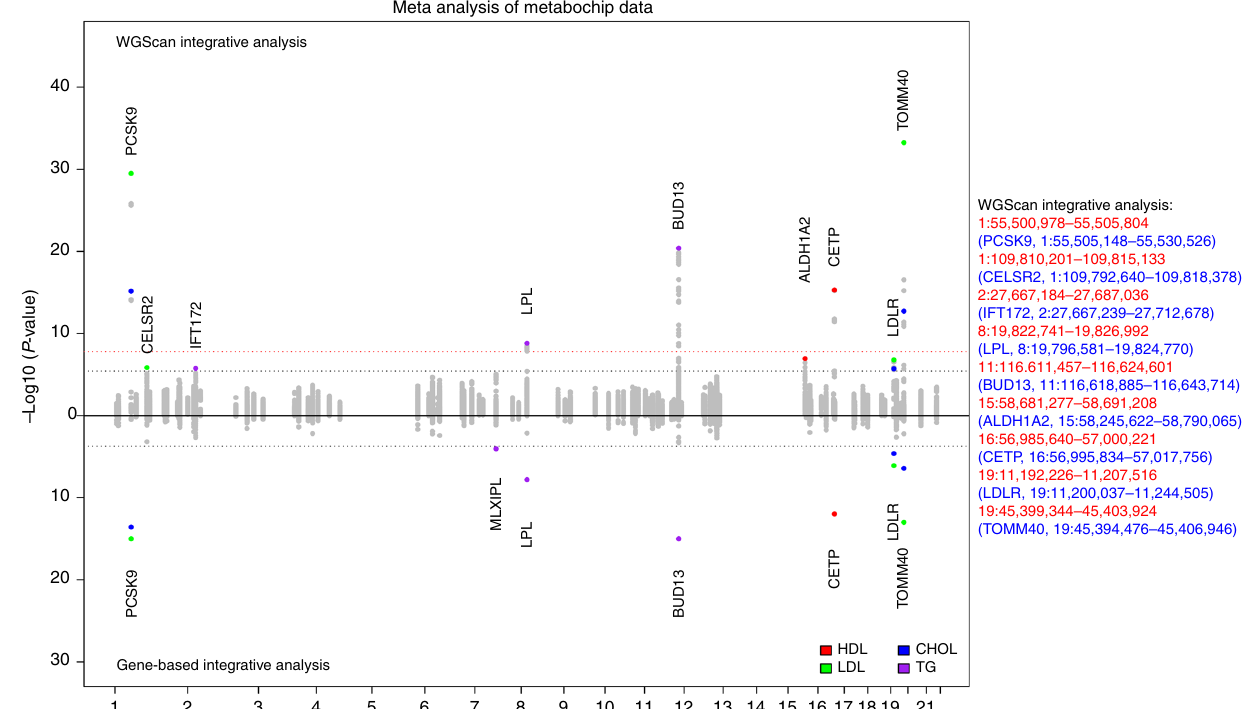
Fig. 3 Application to the Metabochip data. The top panel shows the results of WGScan (sliding-window analysis) with candidate window sizes 5 kb, 10 kb, 15 kb, 20 kb, 25 kb and 50 kb. Each dot corresponds to a window. The highlighted dots correspond to signi fi cant windows and the overlapping genes. The bottom panel shows the results from the gene-based analyses. Each dot corresponds to a gene. The highlighted dots represent signi fi cant genes. For each lipid trait, a signi fi cance threshold (3.75e − 06; black dashed line) is estimated for the minimum p -value of original dispersion and burden tests, and all tests are weighted by GenoNet scores across 127 tissues (in total 256 tests per window). The red dashed line presents the Bonferroni threshold (1.66e − 08). The gene-based signi fi cance threshold (1.88e − 04) is calculated by Bonferroni adjustment based on 266 genes located in the 99 fi ne-mapping regions. The right panel presents the signi fi cant windows (and the overlapping genes) identi fi ed by WGScan. Source data are provided as a Source Data fi le